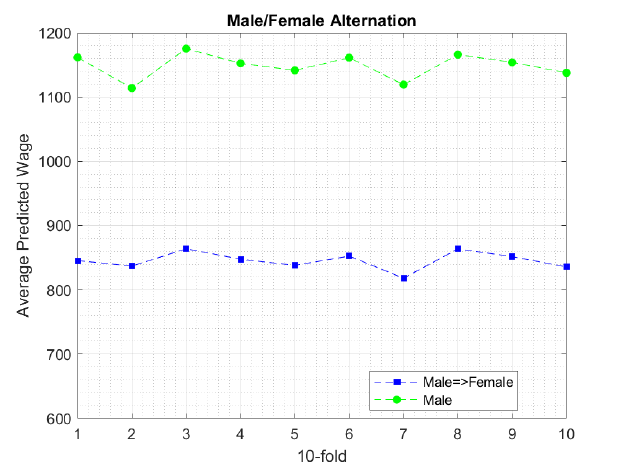
Figure 3. Male to female alternation. The wages of males (in green) decrease when we change the gender attribute to a female (in